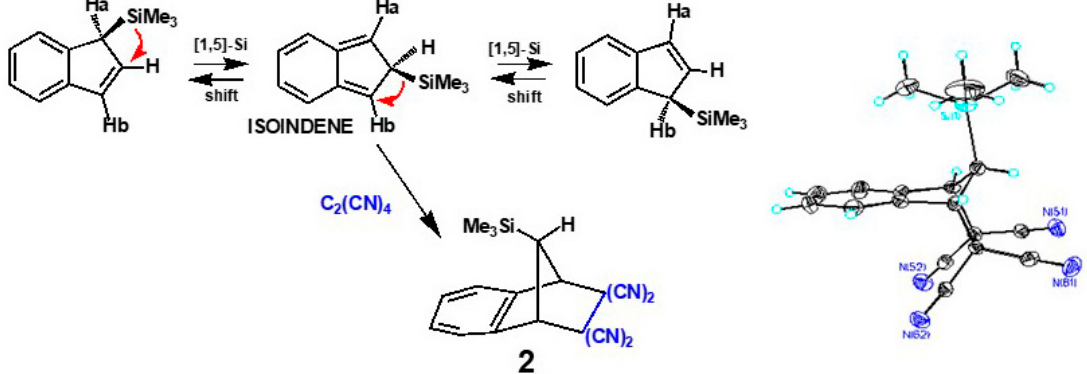
Figure 2. Molecular structure of 2 , the Diels-Alder adduct of TCNE to the isoindene intermediate derived from 1-trimethylsilylindene.